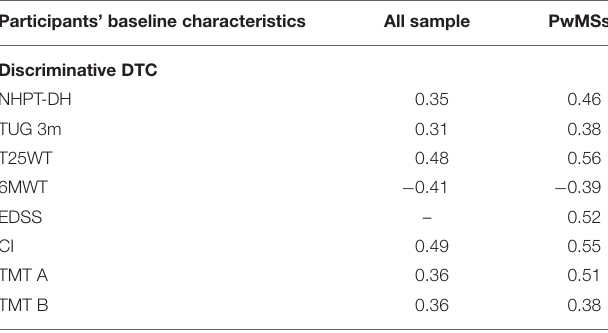
TABLE 4 | Correlation analysis between discriminative DTC (CWT + DS_B) and physical/cognitive baseline characteristics. Participants’ baseline